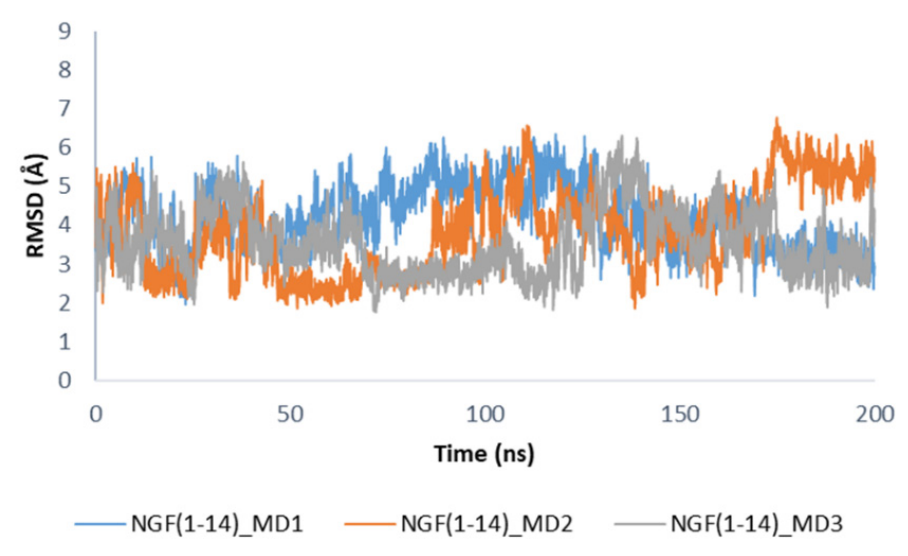
Figure 8. RMSD profiles of NGF(1–14) backbone in the unbound state calculated by using the conformation of the peptide in complex with TrkA as reference structure.